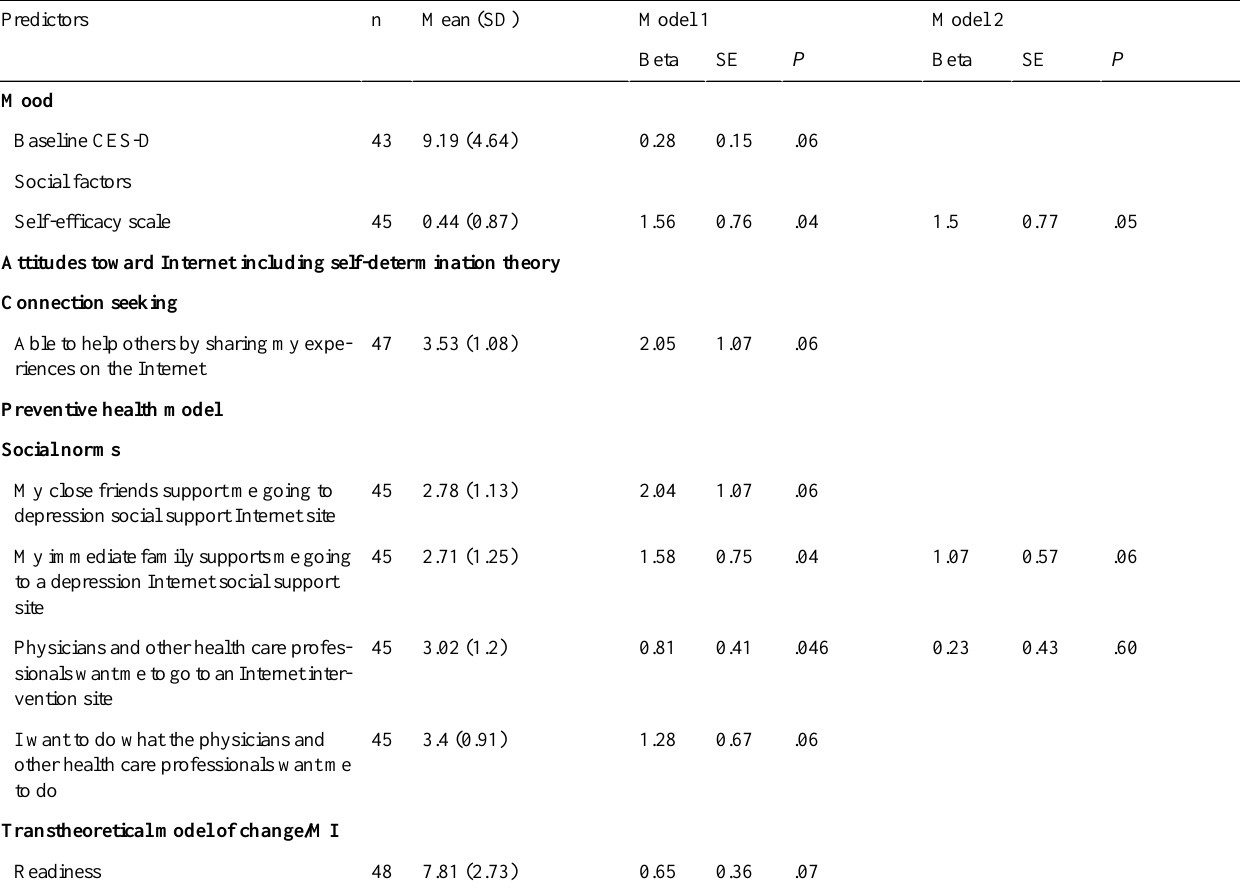
Table 8. Predictors of posts attempted reporting only those with P <.10.